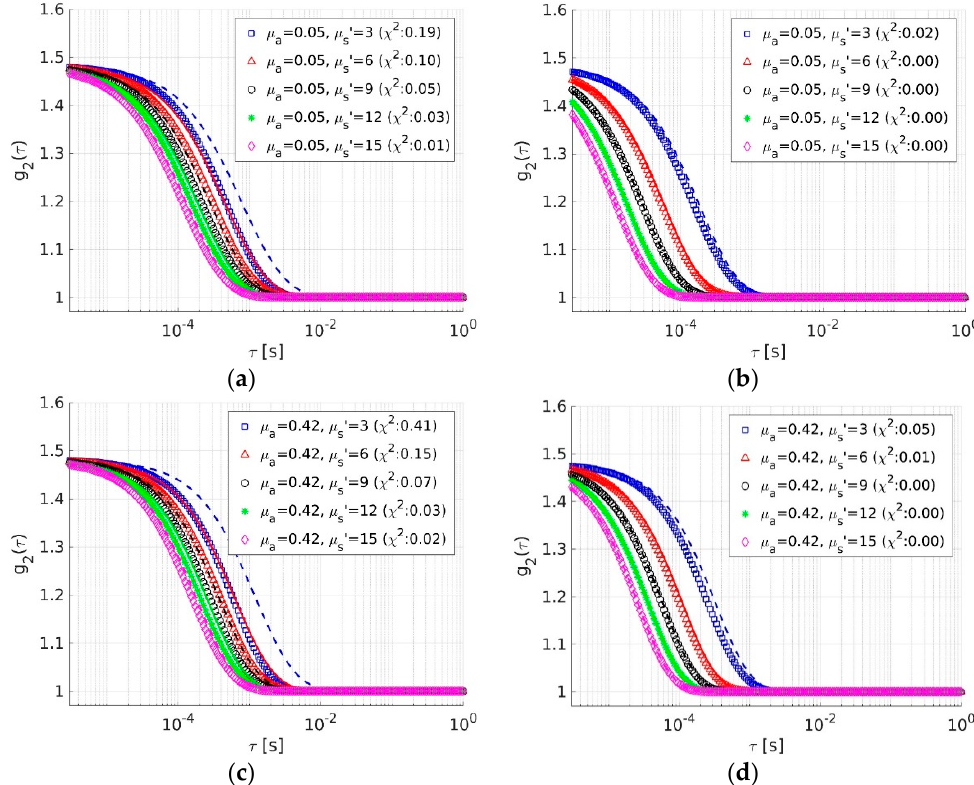
Figure 2. MC simulations (symbols) and forward theoretical calculations using Equation (2) (lines) for media with low and high absorption (top and bottom rows) at SDS of 0.15 and 1.5 cm (left and right columns). Each figure shows data for 5 media with varying scattering distributed between µ (cid:48) s = 3 / cm (squares) to µ (cid:48) s = 15 / cm